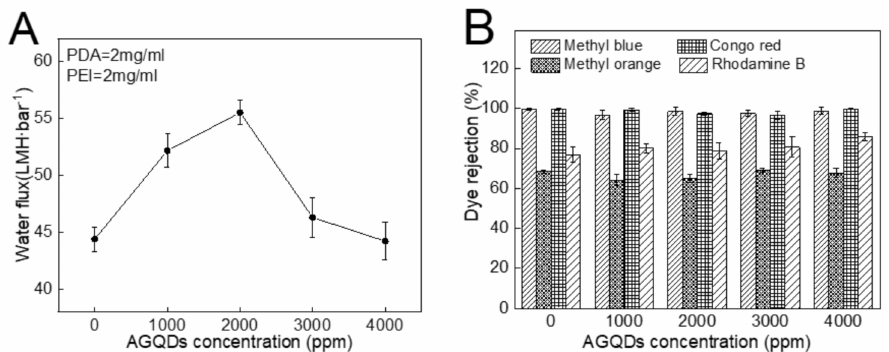
Figure 11. Water flux ( A ) and dye rejections ( B ) of PDA/PEI/AGQDs membranes as a function of AGQDs